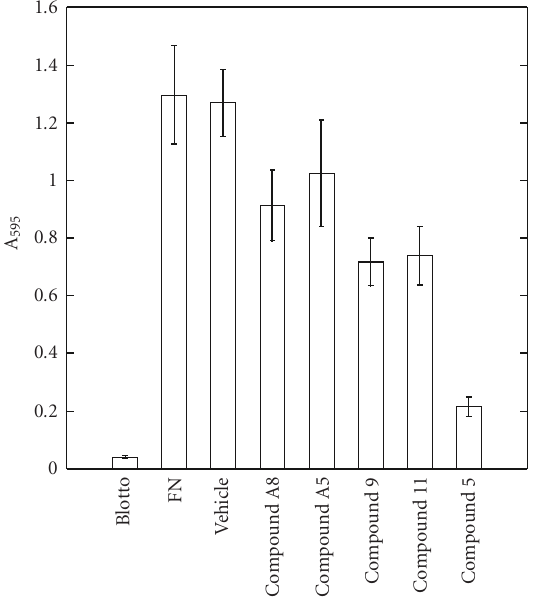
Figure 2: Static 5 hours adhesion of MDA-MB 435 breast cancer cells to purified fibronectin in the presence and absence of test compounds. Concentrations used were 36 ng/ μ L. Adherent cells were stained with crystal violet, solubilized in 1%SDS, and absorbance determined at 570 nm. Values represent mean ± standard